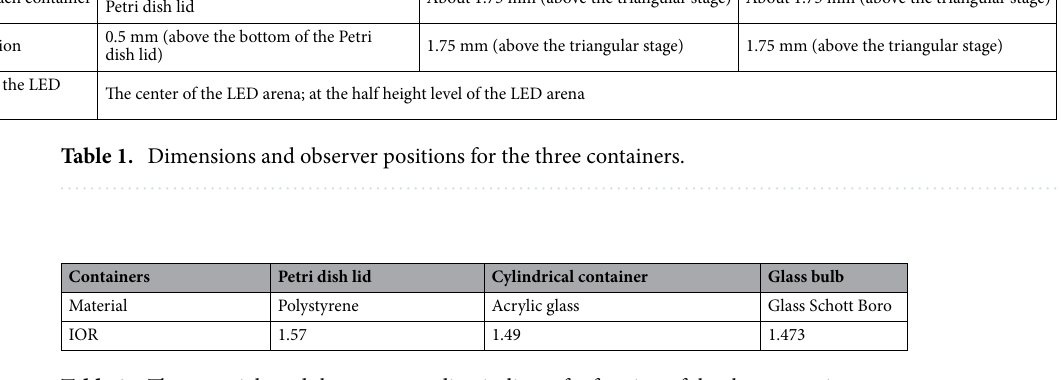
Table 2. The materials and the corresponding indices of refraction of the three